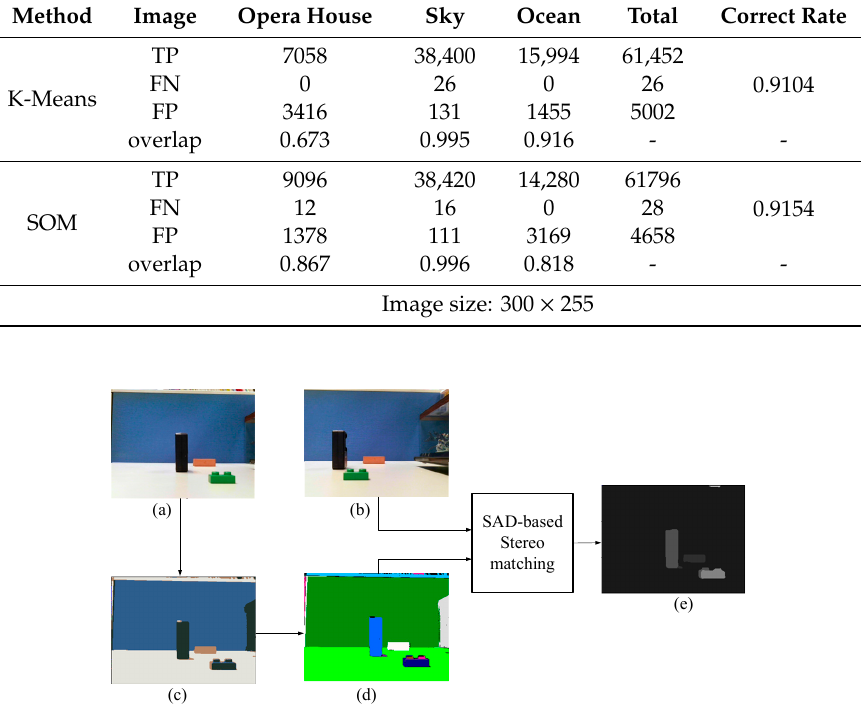
Table 1. Comparison of k-means clustering and the SOM neural network.